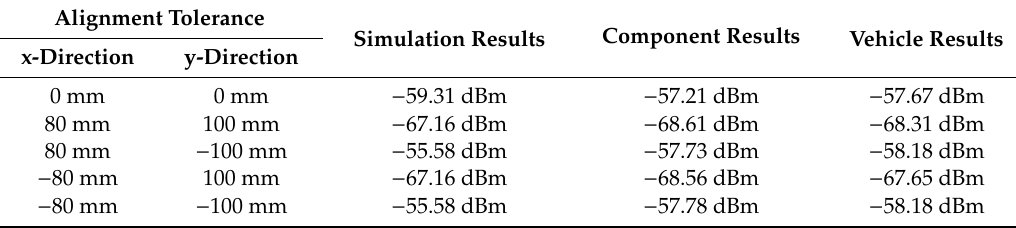
Table 5. Comparison of experimental and simulated results in the + y-direction of the ferrite antenna receiver of the primary